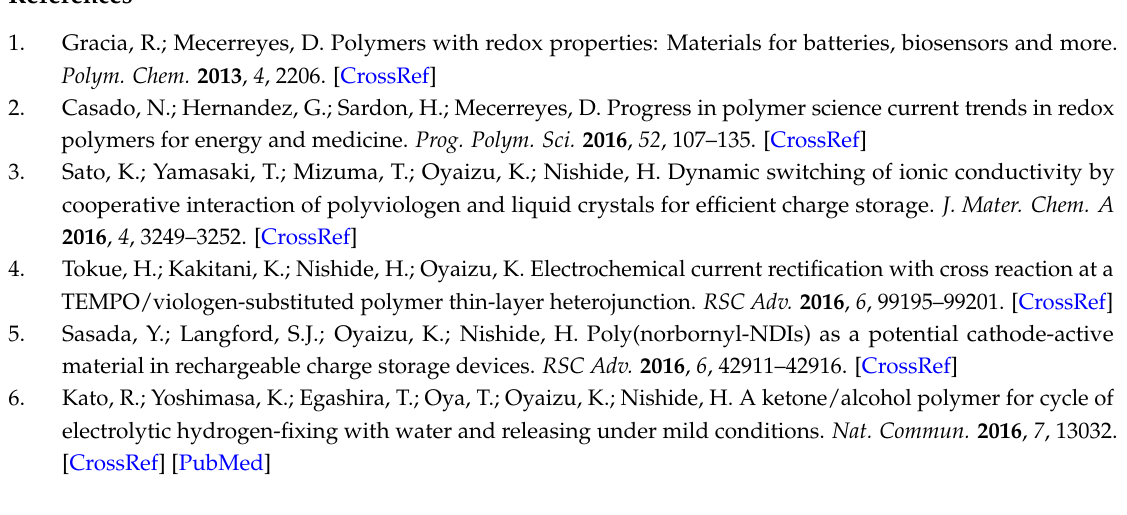
Figure S1: Heat map of the relative electric field intensity in the partially etched electrochromic cell, Figure S2: ( a ) Reflectance and ( b ) cycle performance of an electrochromic device consisting of polyviologen 1 . ( c ) Reflectance and ( b ) cyclability of 2 . 35 mM EMIM TCB in 5CB was used as an electrolyte. Measured absorbance was at 520 and 420 nm for 1 and 2 , respectively, Figure S3: ( a ) Photographs of an electrochromic cell after coloring reaction. The cell was left at open circuit. The counter electrode was partially etched (configuration shown in Figure 5b). ( b ) Absorbance (at 520 nm) change with time revolution at open circuit. The cell consisted of 1 as an EC layer and 35 mM EMIM TCB in 5CB as an